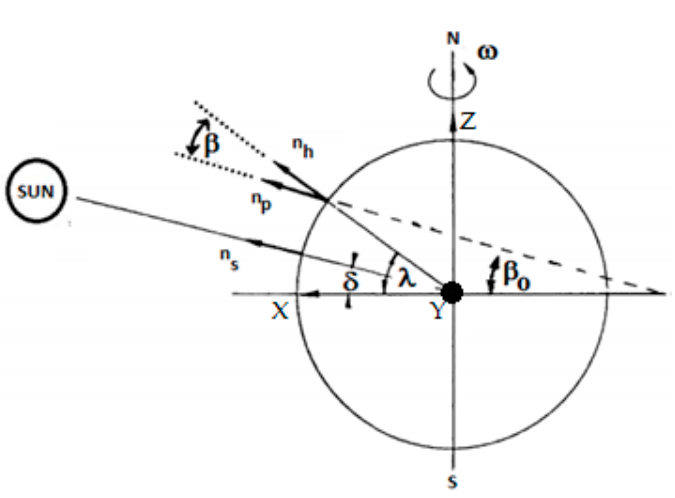
Figure 8. Sunlight ray in Sun–Earth geometry with normal unitary vectors 𝑛 (cid:3035) , 𝑛 (cid:3043) and